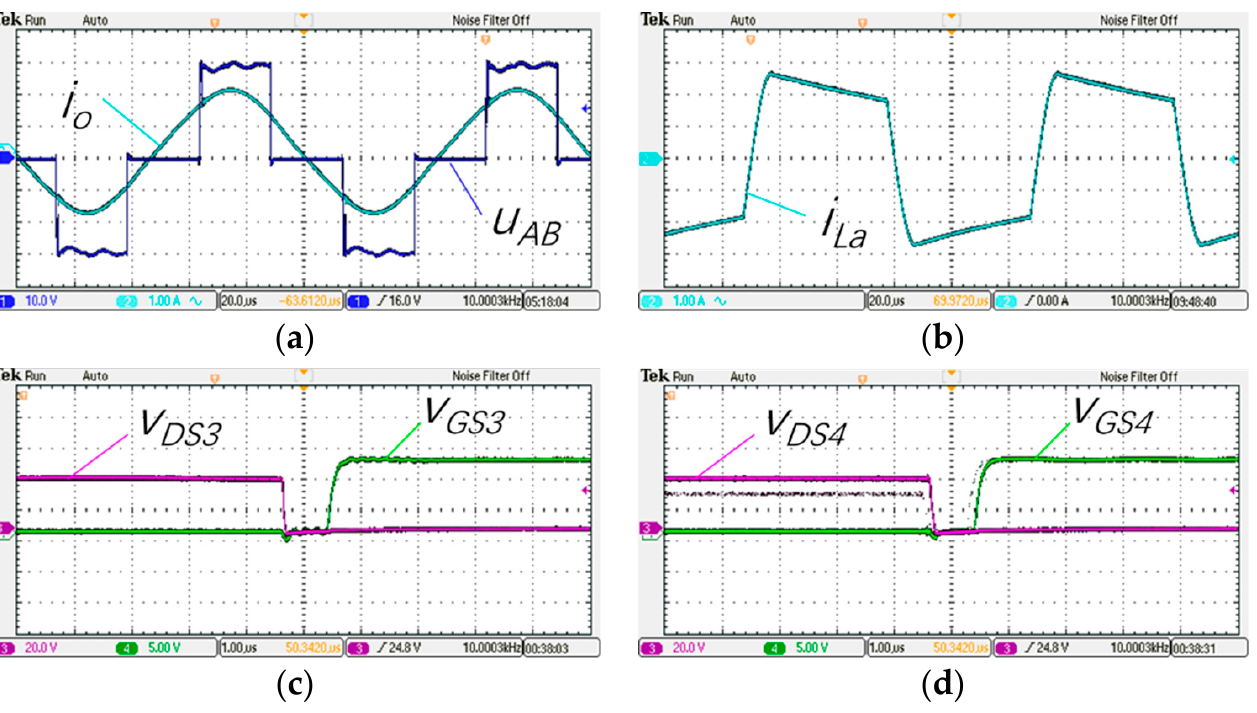
Figure 16. The relevant waveforms with auxiliary current source. ( a ) Load voltage and current waveforms; ( b ) Injection current waveform; ( c ) Q 3 trigger signal and Q 3 drain-source voltage waveform; ( d ) Q 4 trigger signal and Q 4 drain-source voltage waveform.